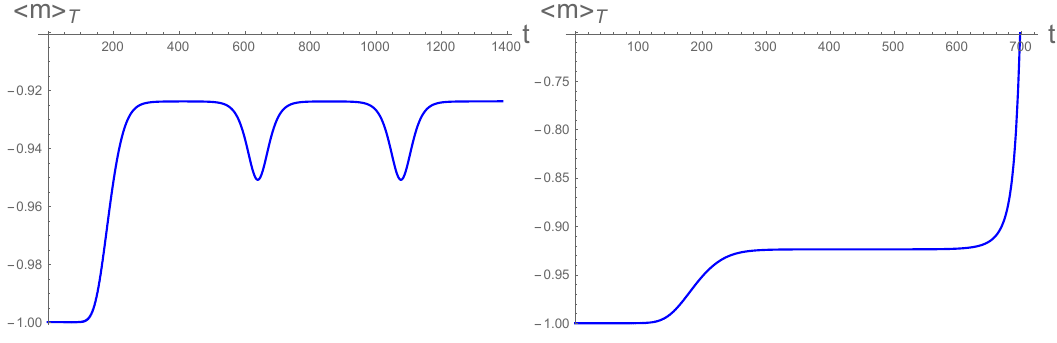
Figure 12 . Left: for (cid:12) = 296 : 1971924 > (cid:12) c , we obtain a TMS. Right: for (cid:12) = 296 : 1971680 < (cid:12) c , the system undergoes gravitational collapse.